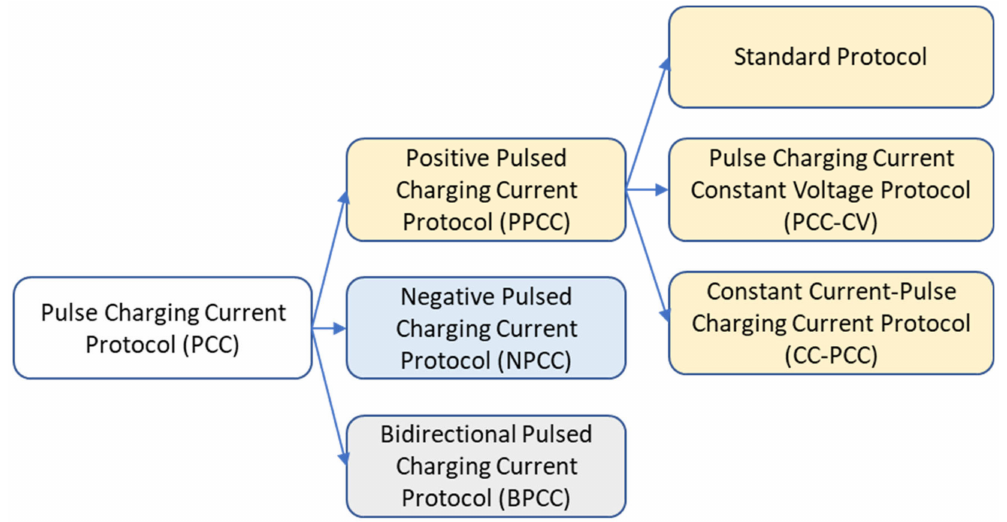
Figure 6. Overall schematic diagram of the Pulse Charging Current (PCC)